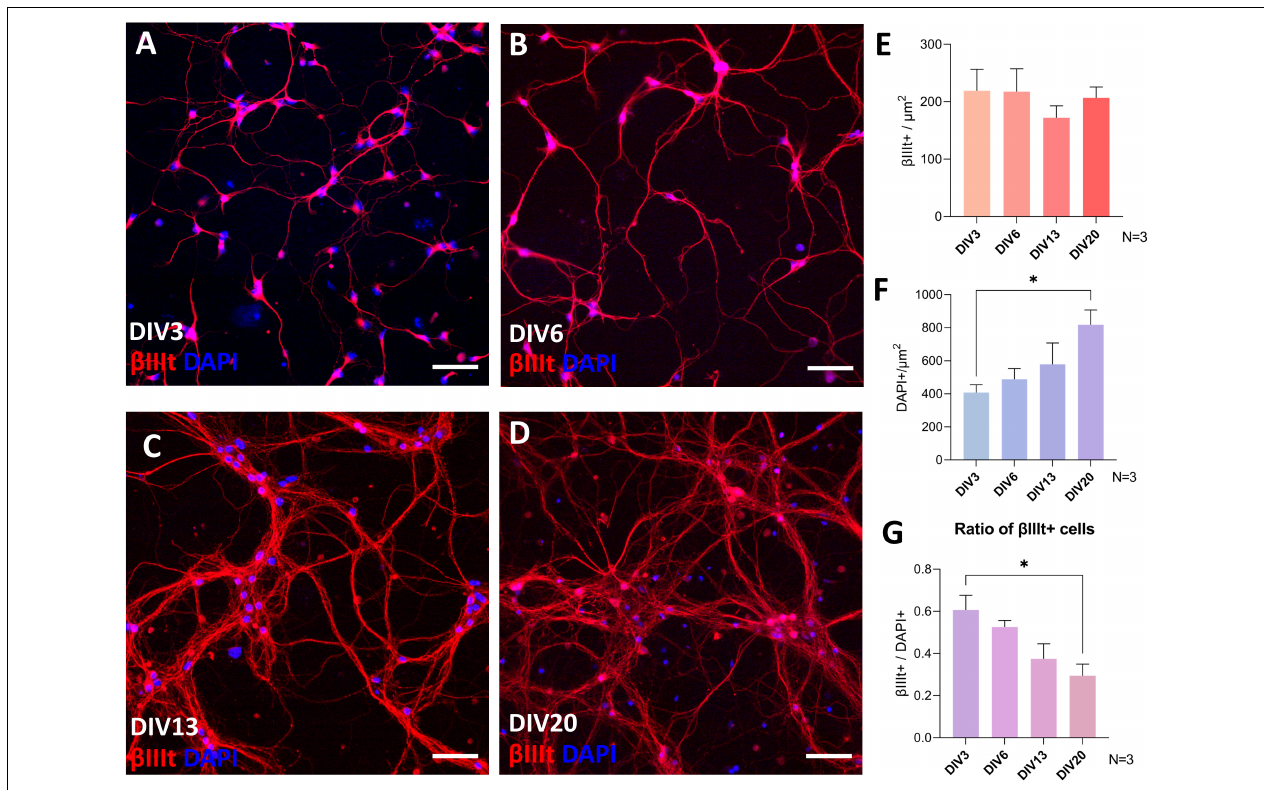
FIGURE 2 | β III tubulin and DAPI immunocytochemistry analysis of the cultures during day in vitro (DIV) 3 (A) , DIV6 (B) , DIV13 (C) , and DIV20 (D) . The number of neurons was stable during cultivation (E) , but the number of cells assessed by DAPI increased continuously (F) , which led to a decrease in the ratio of neuronal population in the culture (G) . Scale bars: 50 µ m. Data are shown as means + SEM of N = 3 biological replicate cultures; * p <